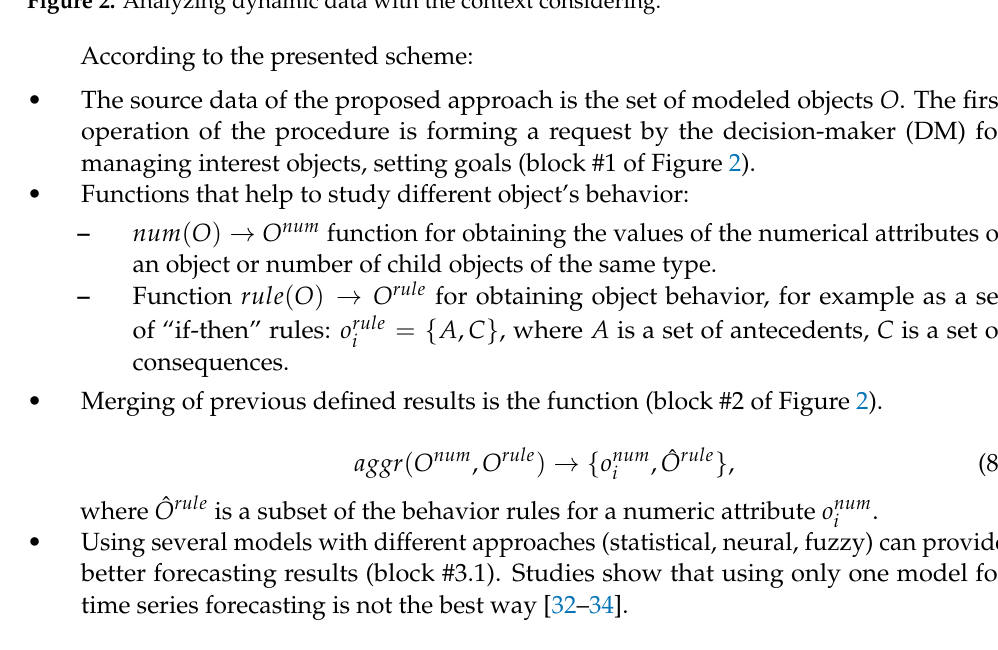
Figure 2. Analyzing dynamic data with the context